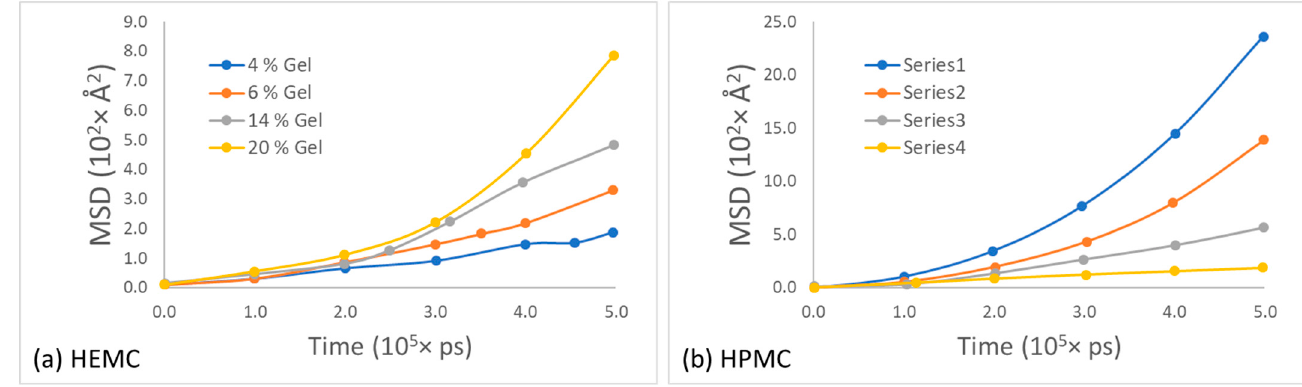
Figure 15. Mean square displacement of polymer at different concentrations of gel for: ( a ) HEMC and ( b ) HPMC.